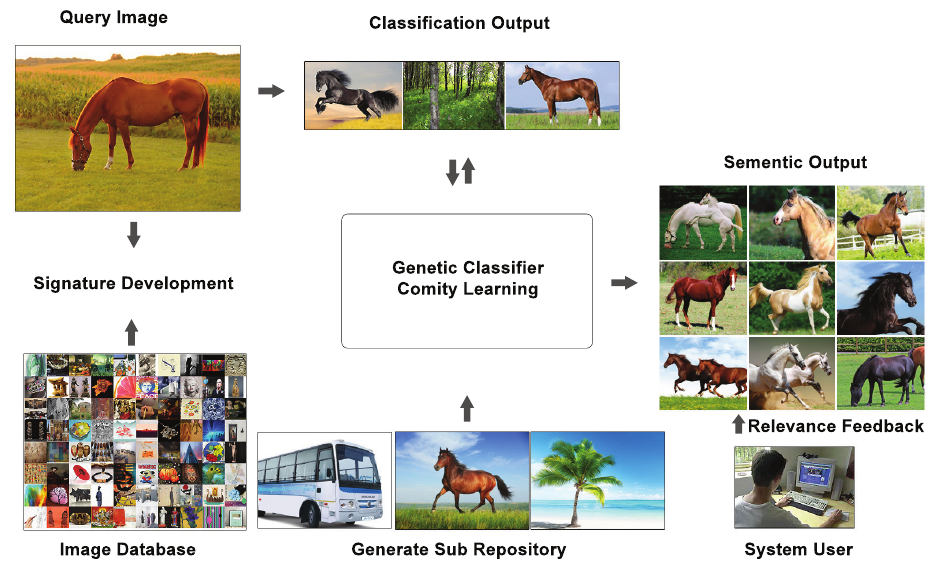
Figure 2. Architecture of the Proposed